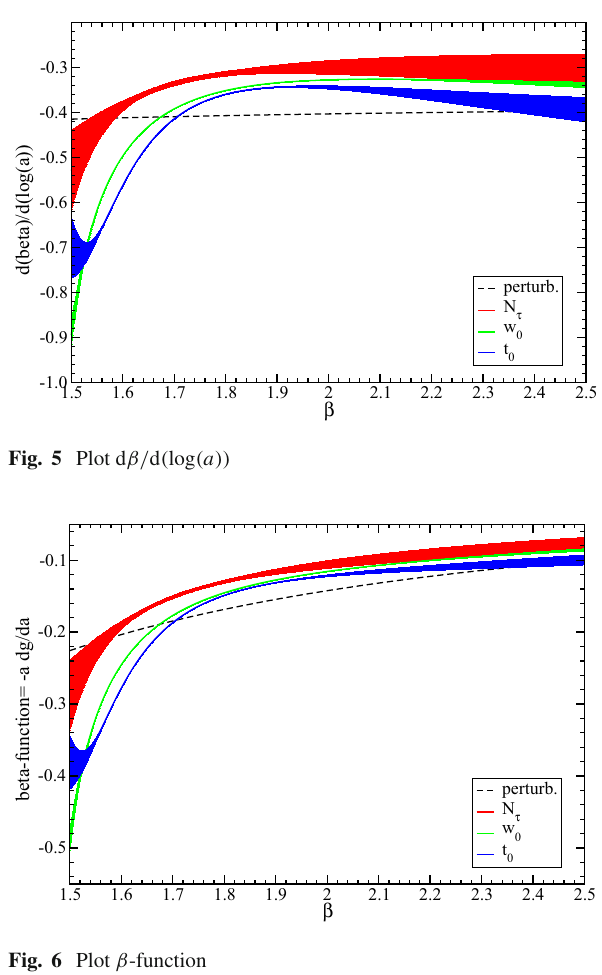
perturbative dashed line present in the plots has been deter- mined considering only Eq. (6). We have three different results which are not compatible with each other at low β ,